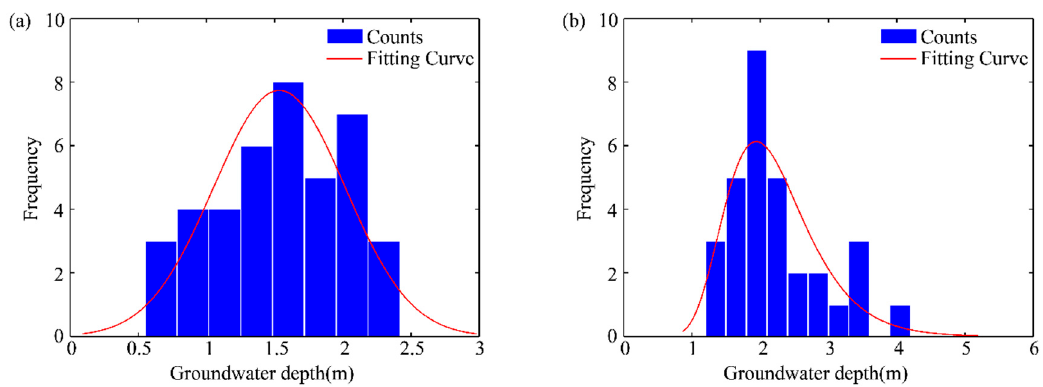
Figure 9. Panel ( a ): the relationship between groundwater depth and the growth frequency of P. australis ; Panel ( b ): the relationship between groundwater depth and the growth frequency of N. tangutorum .